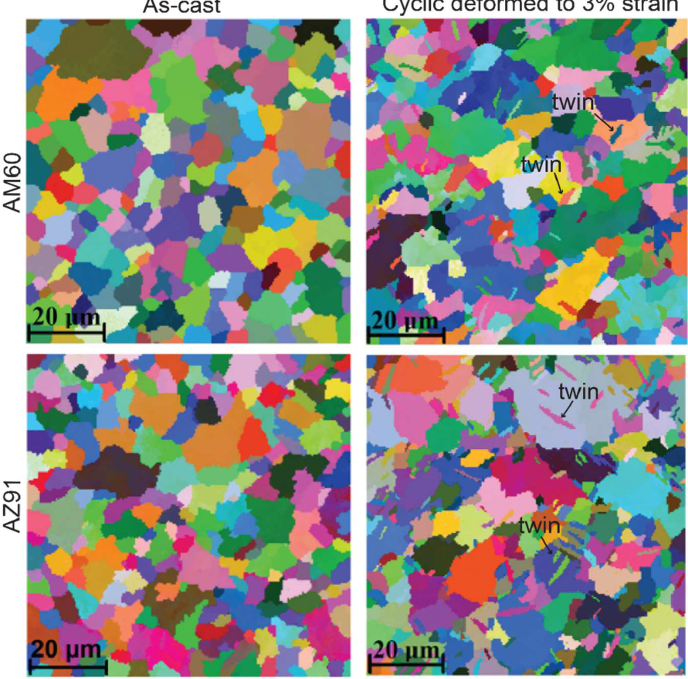
Figure 8. EBSD maps of AM60 and AZ91 showing twin-free as-cast microstructure and twin formation in deformed microstructure.